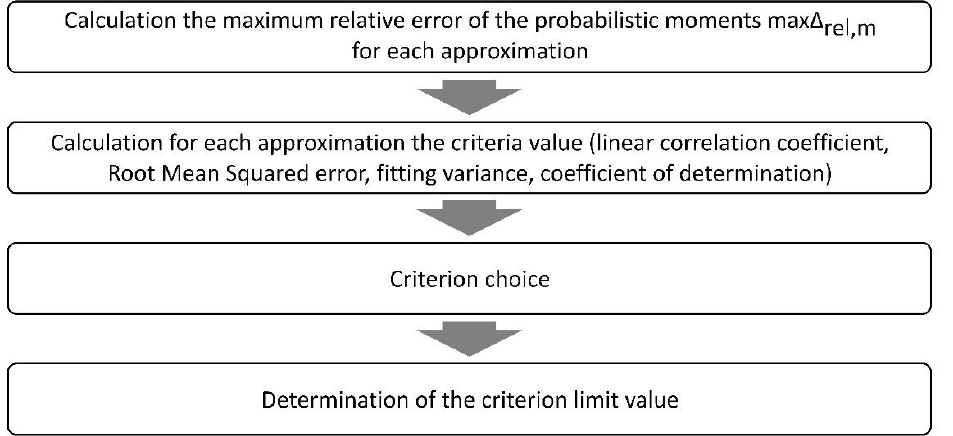
Figure 8. Scheme of the third part of the Figure 8. Graphical representation of the response function method for n = 11 and Δ b / b 0 = 0.05 (blue points — discrete data, red curve — approximation).